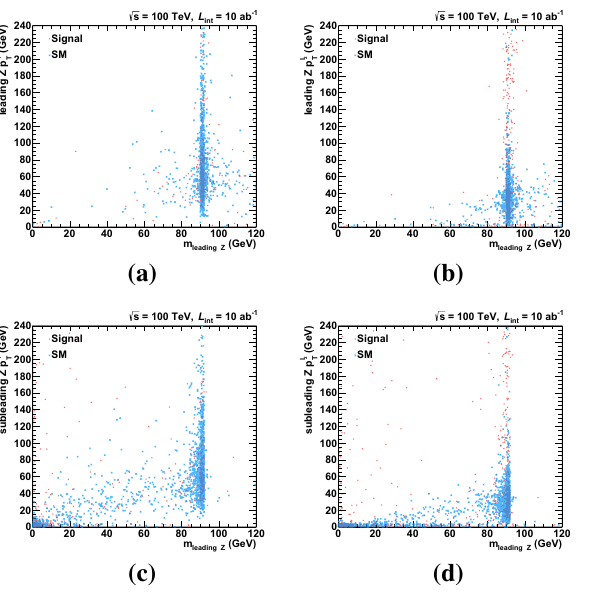
Fig. 4 Transverse momentum distributions of a leading lepton, b sub- leadingleptonoftheleading Z bosonvsitsinvariantmassandtransverse momentum distributions of c leading lepton, d sub-leading lepton of the sub-leading Z boson vs its invariant mass in the 4 μ channel